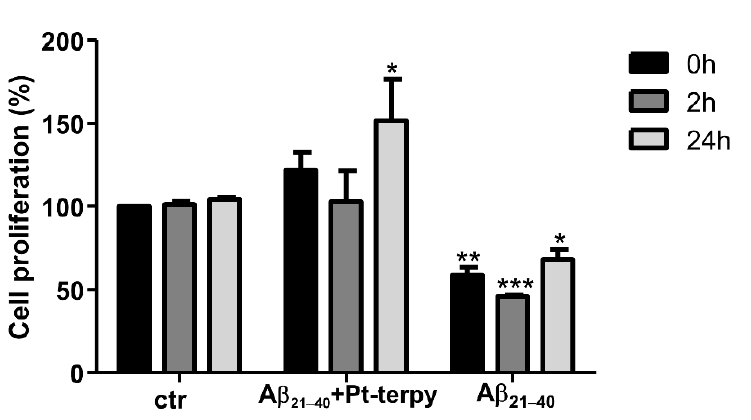
Figure 6. Cell proliferation assays in SH ‐ SY5Y cells treated with A β 21–40 alone and A β 21–40 : Pt ‐ terpy at 1:5 peptide to metal compounds molar ratio at three different times. Statistical analysis was calculated by GraphPad Prism 7 by two ‐ way Anova with Dunnett’s multiple comparison test (* p ≤ 0.05, ** p ≤ 0.005 and *** p ≤ 0.0005 vs. basal (at corresponding time)).